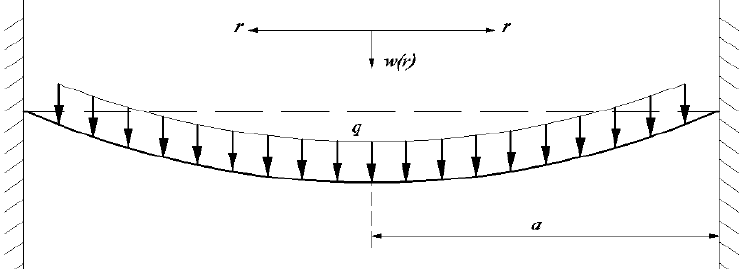
Figure 2. Sketch of circular thin film under uniformly distributed transverse load.